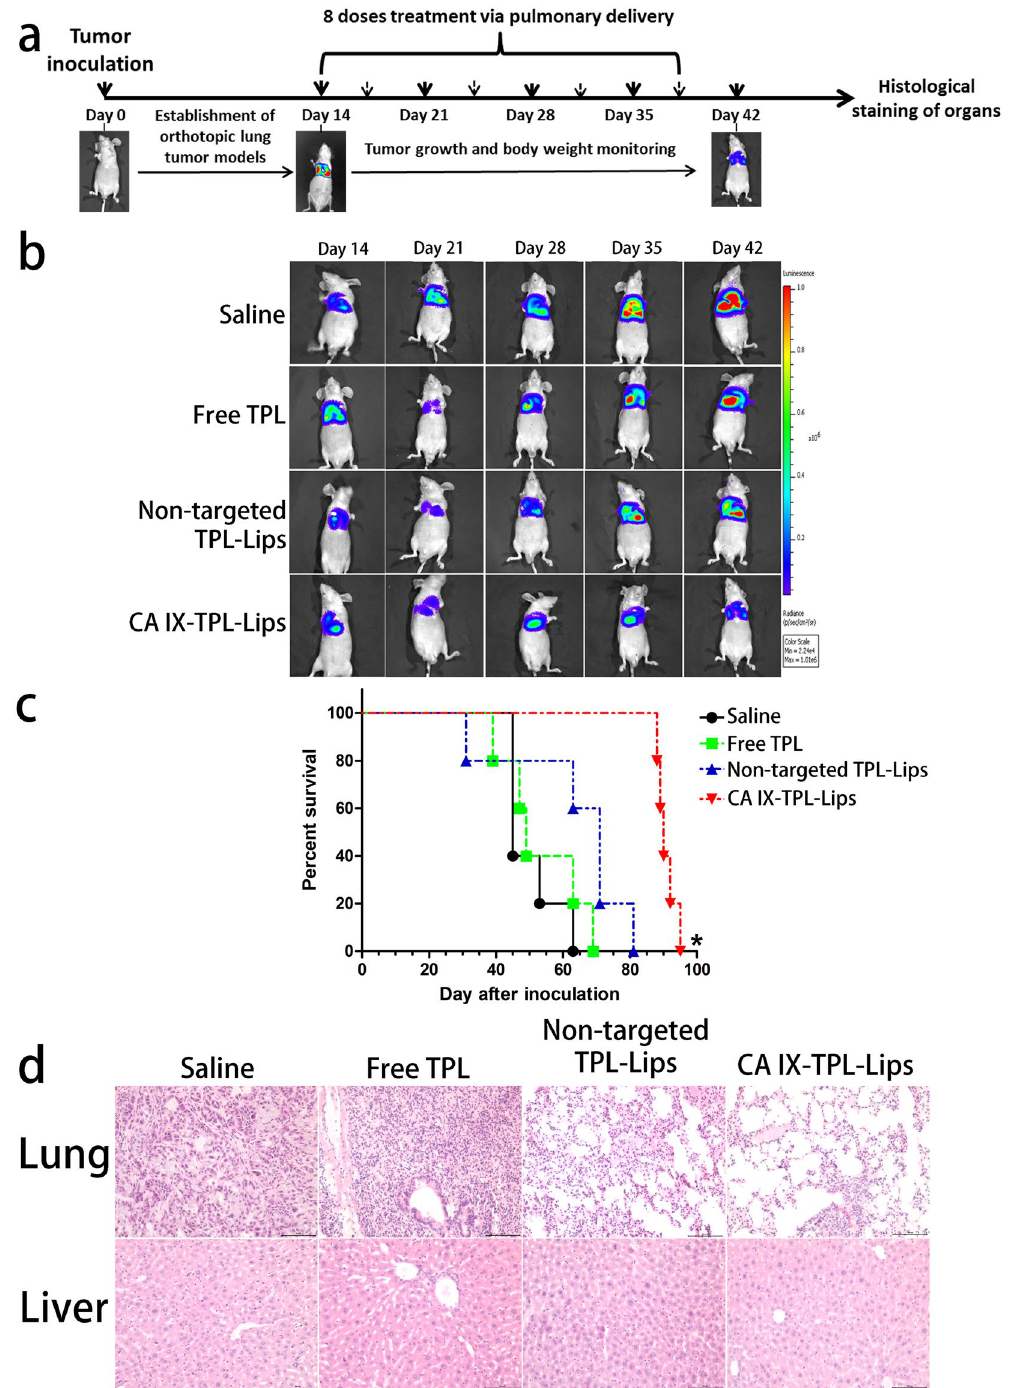
Figure 7. Anti-cancer effects of CA IX-TPL-Lips in mice with orthotopic lung tumors. ( a ) Treatment schedule of TPL formulations in orthotopic A549-Luc tumor-bearing BALB/c nude mice; ( b ) Representative serial images of bioluminescence change in mice during treatment with different formulations of TPL including CA IX-TPL-Lips, non-targeted TPL-Lips, free TPL solution and saline as a control (n = 5) using the IVIS ® Lumina XR system. ( c ) Survival curve of mice with orthotopic lung tumors following administration of TPL formulations. * p < 0.05, compared with saline; ( d ) Histological staining of organs following pulmonary administration of TPL formulations. Scale bars, 100 μ